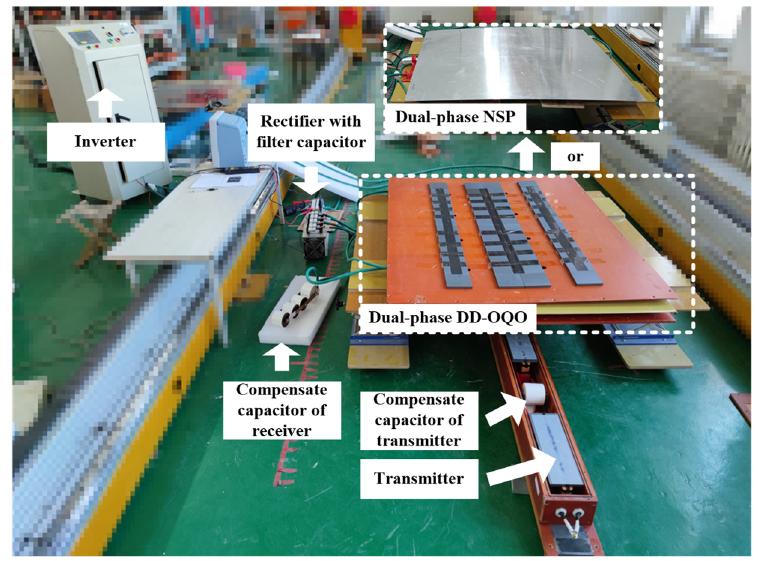
Figure 10. Experimental system for comparing the dual-phase NSP receiver and the dual-phase DD-OQO receiver.